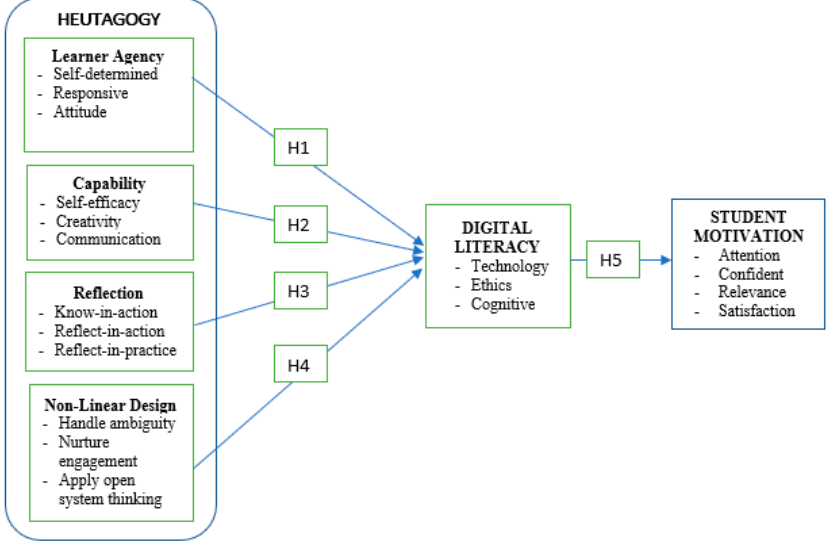
Figure 1. Research